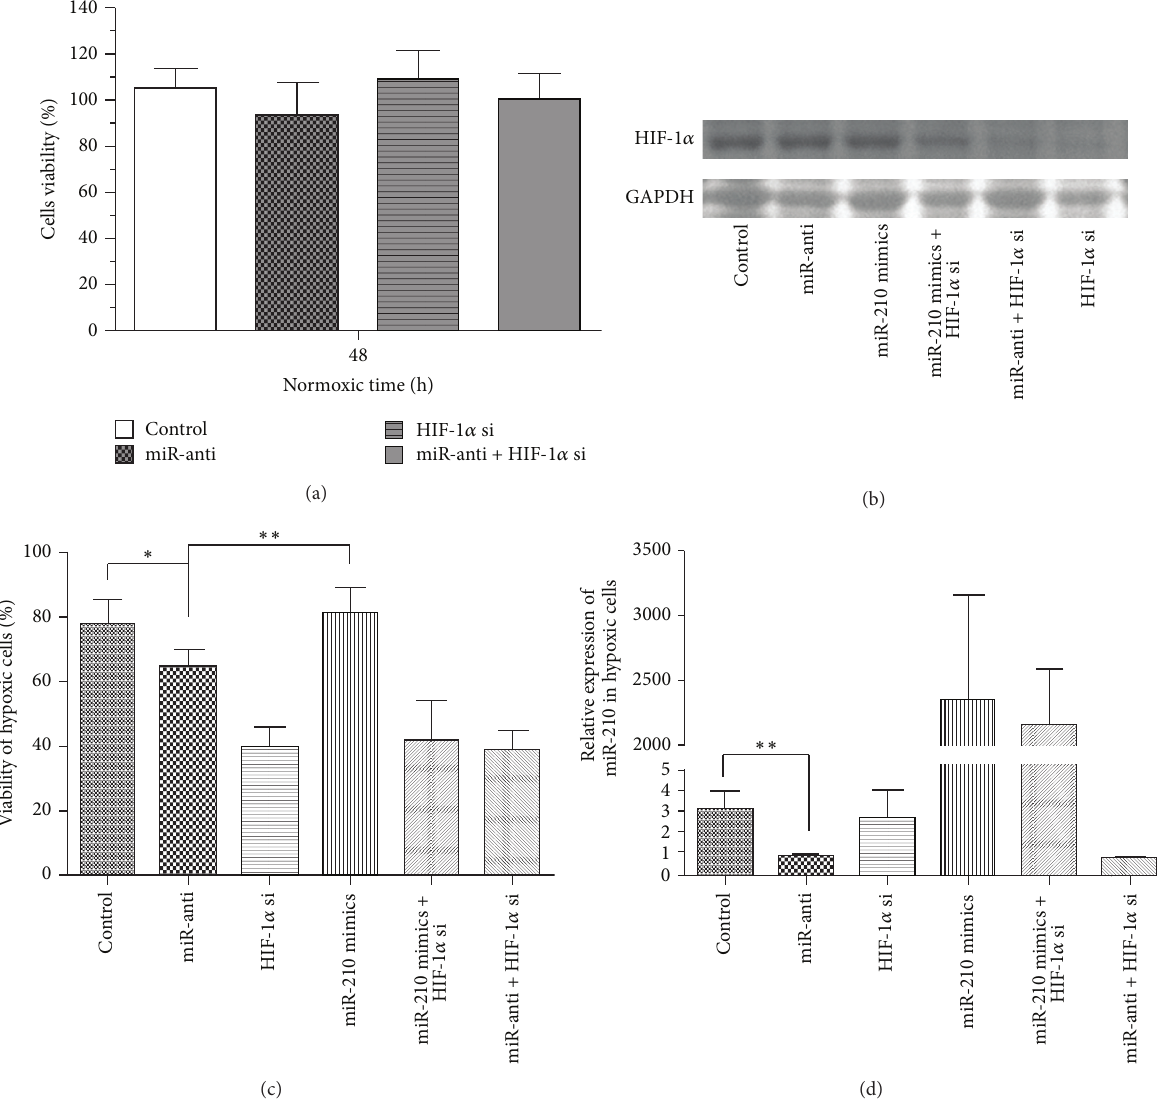
Figure4:DownregulatedmiR-210decreasedviabilityinhypoxicC28/I2cellsdependingonHIF-1 𝛼 .Cellviabilitywasdetectedafter48culture by MTT assay after being treated with miR-210 mimics, miR-anti, or HIF-1 𝛼 si on normoxia or hypoxia. Data of three individual experiments was normalized and statistically analyzed by ANOVA. (a) Cell viability on normoxia. (b) Western plot assay of HIF-1 𝛼 protein in hypoxic cells treated with miR-210 mimics, miR-anti, or HIF-1 𝛼 si. (c) Cell viability on hypoxia ( ∗ 𝑃 < 0.05 , ∗∗ 𝑃 < 0.01 ). (d) Expression of miR-210